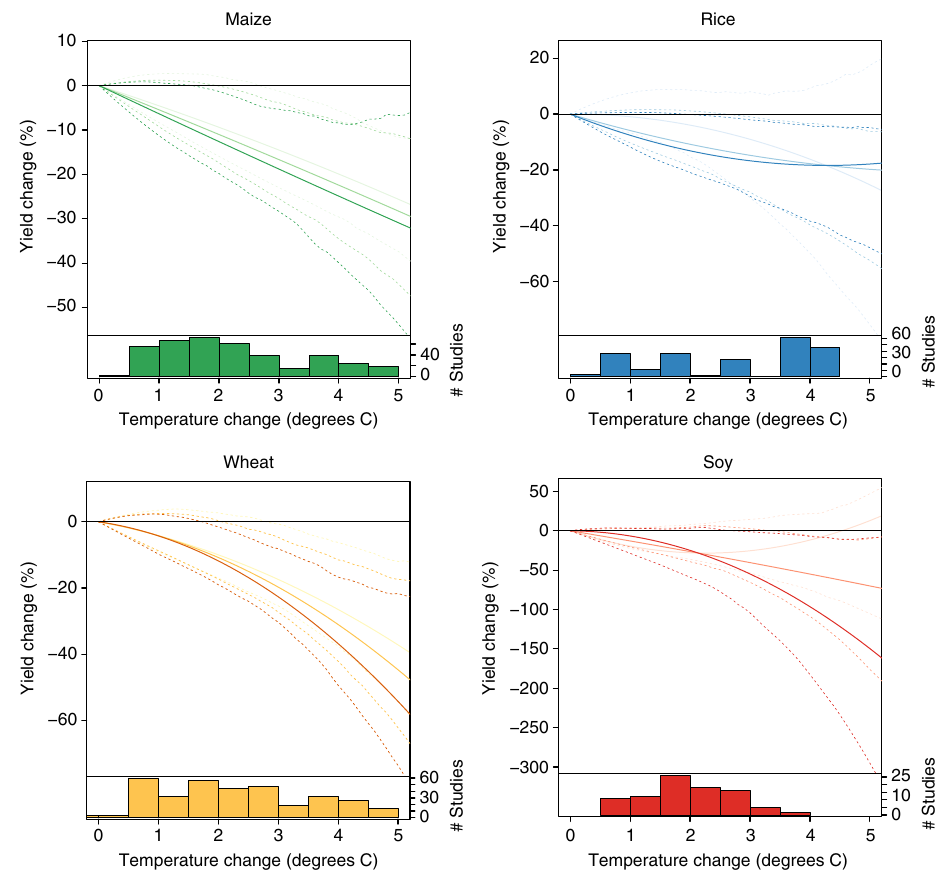
Fig. 1 Impacts of temperature change on yields of four major crops. Based on a meta-analysis of 1010 point-estimates from 56 studies (see Methods section). Darkest, middle, and lightest lines show responses at the 75th, 50th, and 25th quantiles of baseline growing-season temperature, respectively. Dashed lines show the 95% con fi dence interval based on 750 block bootstraps, blocking at the study level. Plotted response curves are for temperature only and do not include CO 2 fertilization or adaptation. Temperature changes are relative to a local 1995 – 2005 baseline. The histograms show the number of observations by crop and level of warming used to estimate the response functions. In subsequent analyses, yield losses > 100% are set to losses of